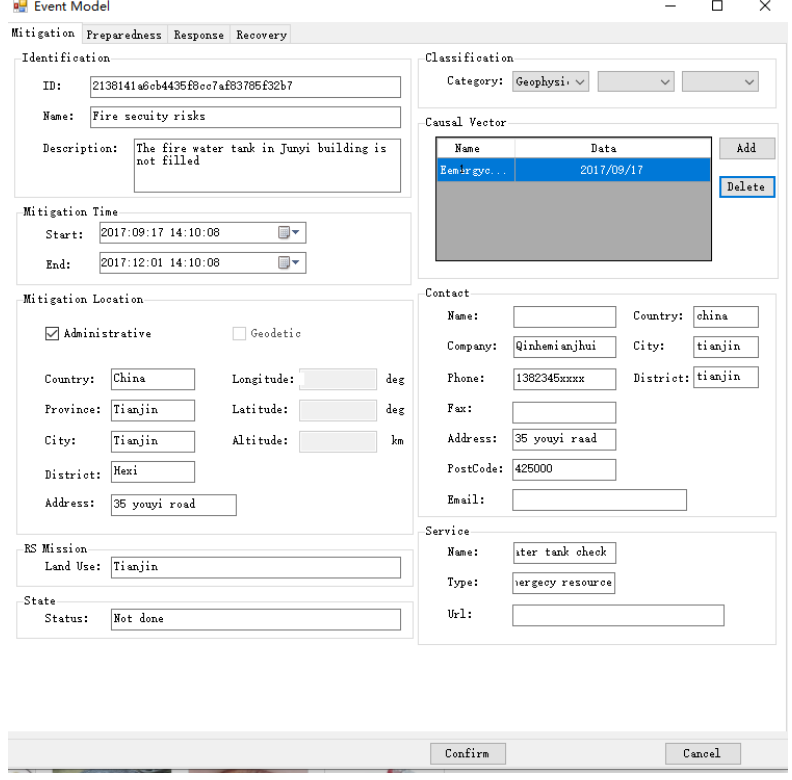
Figure 3. Urban fire event modeling function